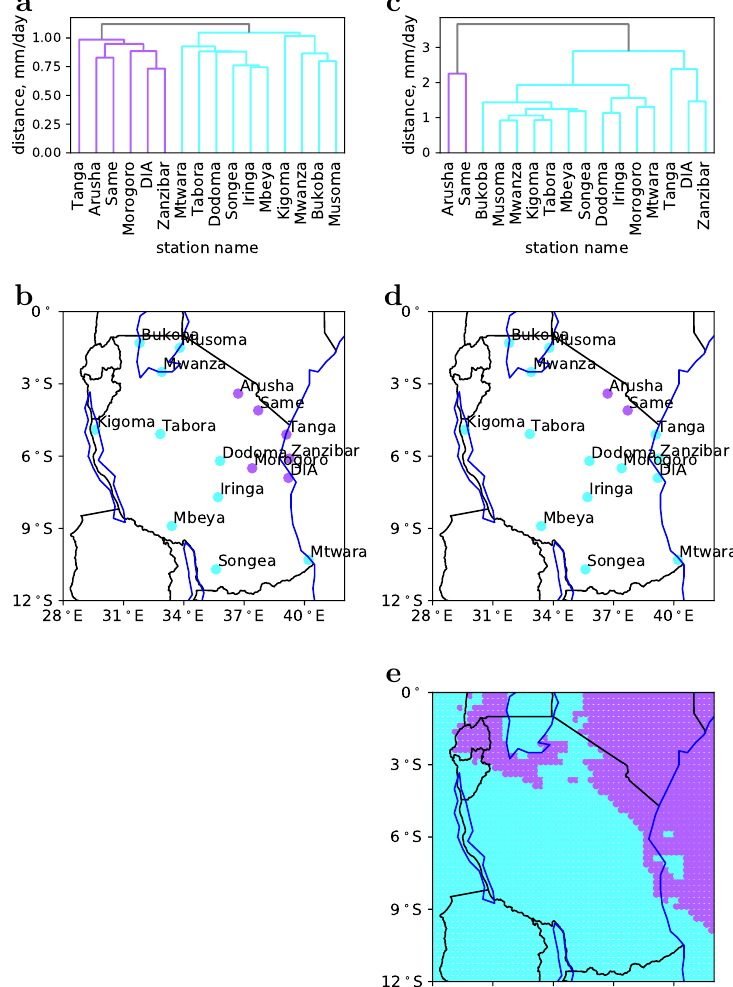
Figure 8. Clustering of TMA stations and classification of grid cells over Tanzania using TMA or CMORPH precipitation 5-day moving averages. ( a , b ) Dendrogram and clustering of TMA stations based on TMA data. ( c – e ) Dendrogram and clustering of TMA stations, and classification of Tanzania grid cells based on CMORPH